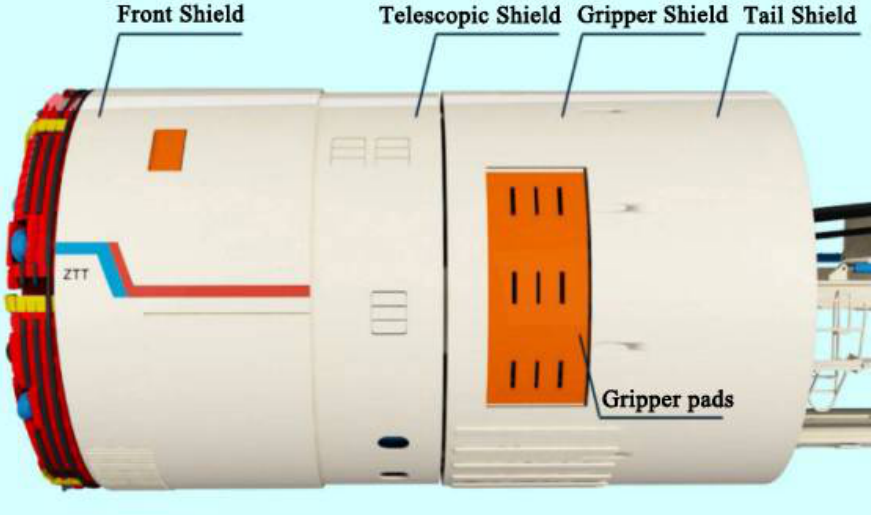
Figure 2. Mainframe of double-shield TBM (Reprinted with permission from Ref. [29]. 2018, Qing- dao Metro Line 4 Civil Engineering Zone 10 Project Manager Department.)